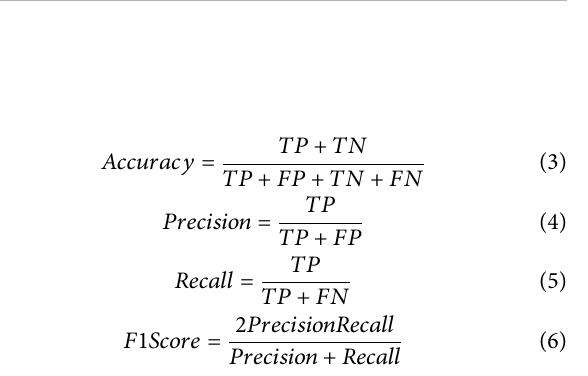
TABLE 6 | The interpretation of TP, FP, TN, and FN. TP is the number of correctly predicted dead samples, TN is the number of correctly predicted survived samples, FP is the number of wrongly predicted dead samples, and FN is the number of wrongly predicted survived samples. Ground